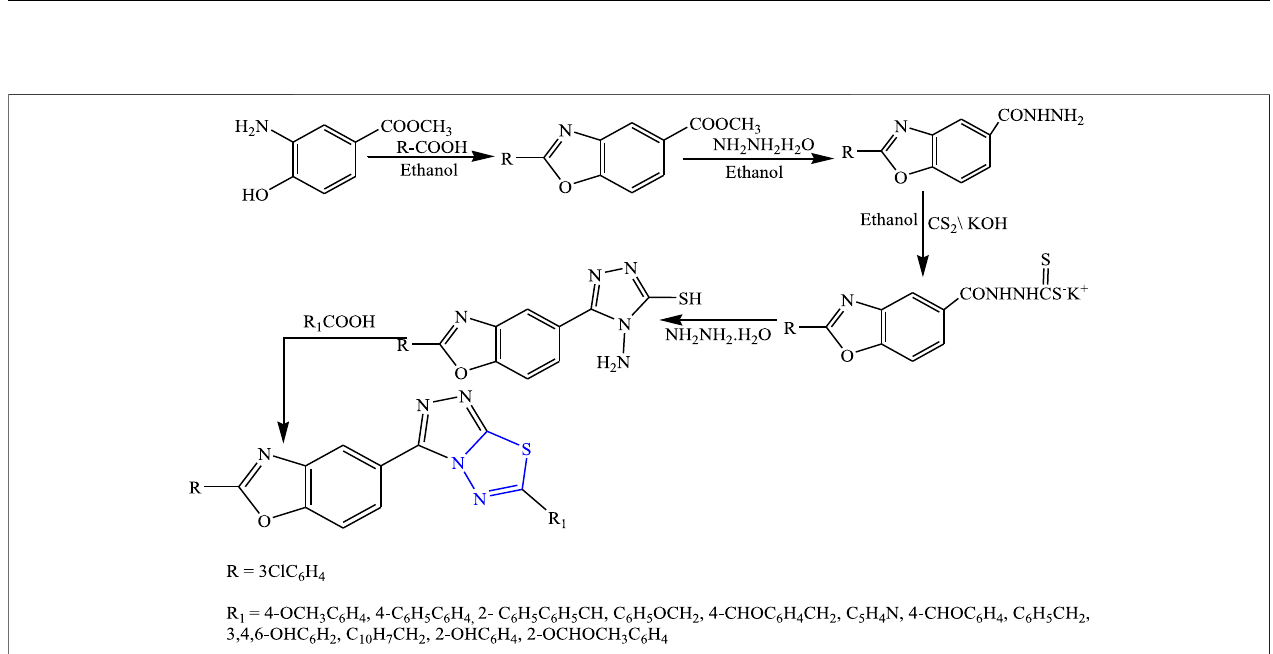
FIGURE 8 | Systematic scheme for synthesizing 1,2,4-triazole-1,3,4-thiadiazole derivatives.